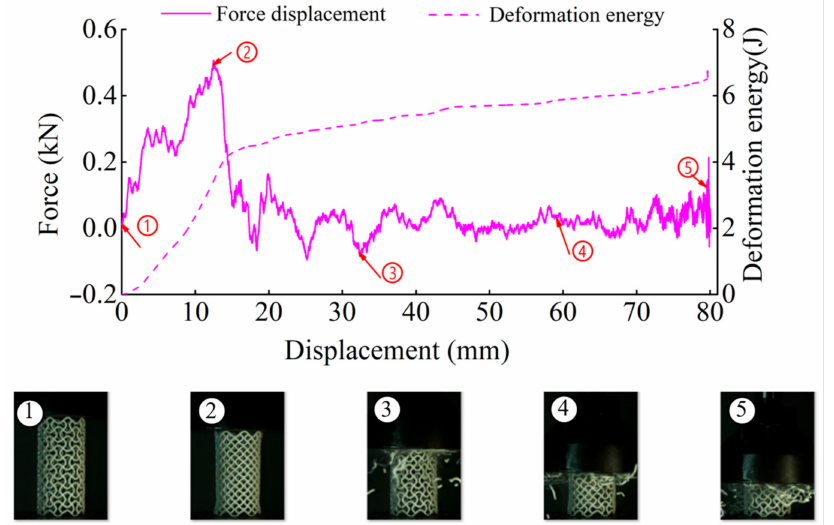
Figure 18. The results of dynamic tests of CCHT3 (1–5 stages of deformation during the dynamic compressive